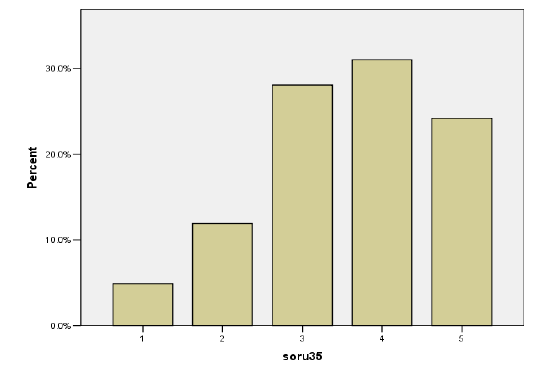
Figure 17. Should case studies and role playing be implemented extensively for accounting courses?